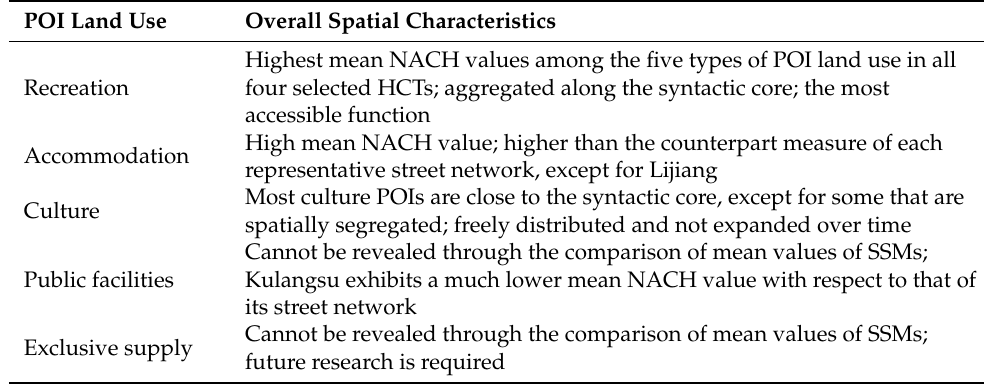
Table 5. The overall characteristics of the five types of POI land